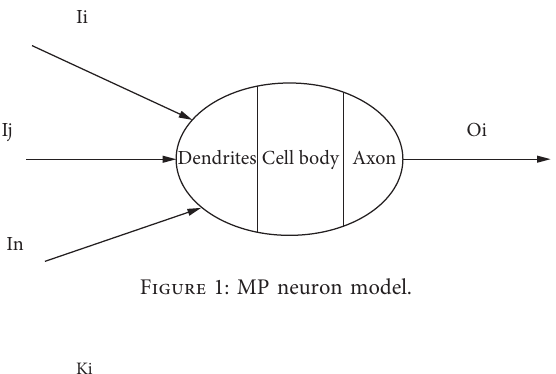
Figure 1: MP neuron model.